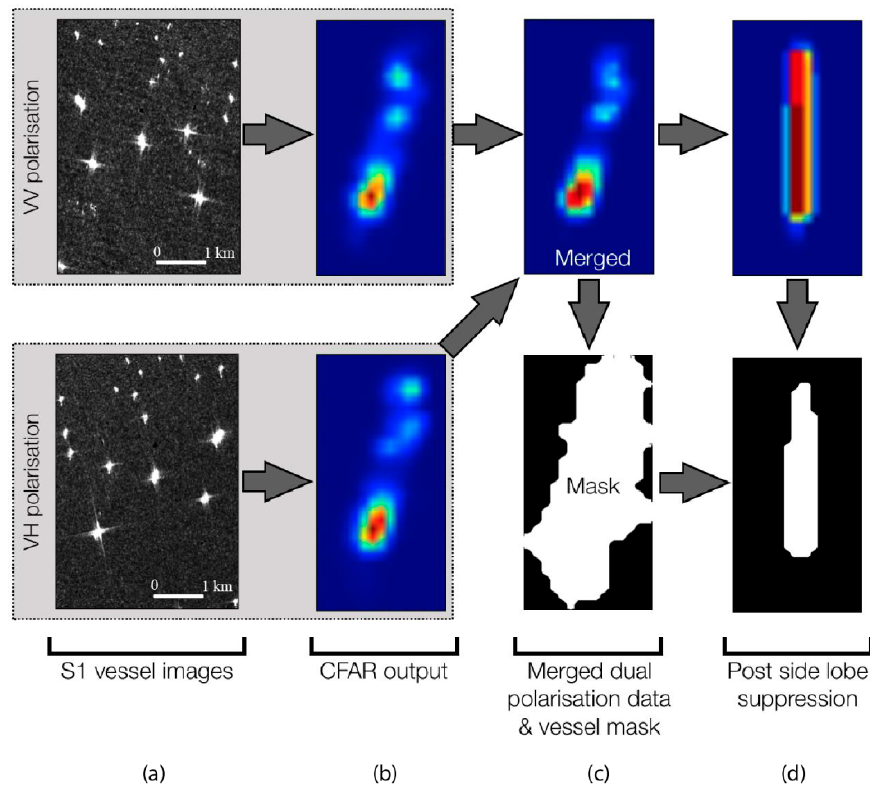
Figure 5. Pre-screening and detection of Sentinel-1 vessels. Columns from left to right show: ( a ) Sentinel-1 imaging of vessels; ( b ) output of the constant false alarm (CFAR) detector; ( c ) merging of dual polarisation data and vessel mask; and ( d ) output after side-lobe suppression.